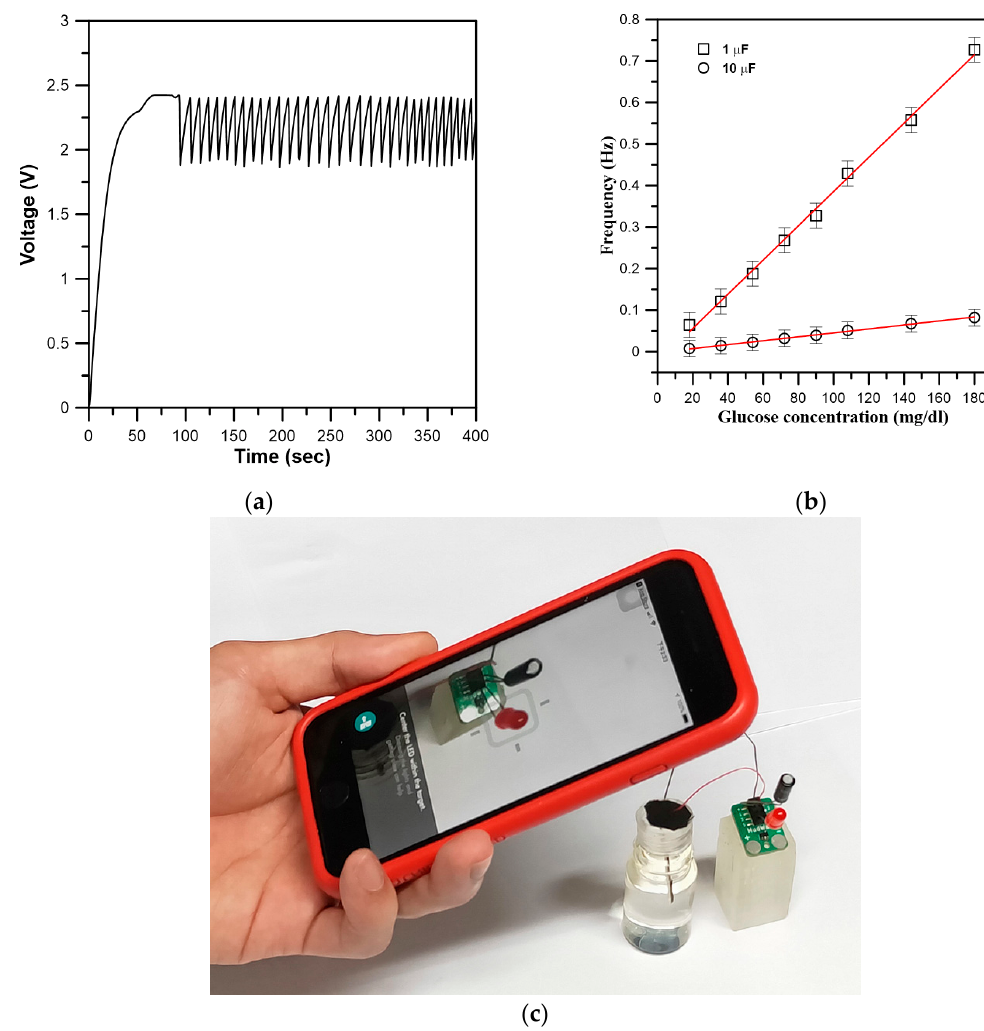
Figure 7. ( a ) Voltage variation of the charging and discharging cycles of the N-EFC operated with a charge pump IC and 1 μ F capacitor in the presence of 70 mg/dl glucose concentration. The charge/discharge cycle was observed at 0.25 Hz frequency. ( b ) The variation in the LED blinking frequencies with respect to various glucose concentrations ranging from 10–180 mg/dl for the charge pump IC connected to a 1 μ F and 10 μ F capacitor. ( c ) An image of a smartphone with an App to determine the glucose concentration by measuring the LED blinking frequencies.